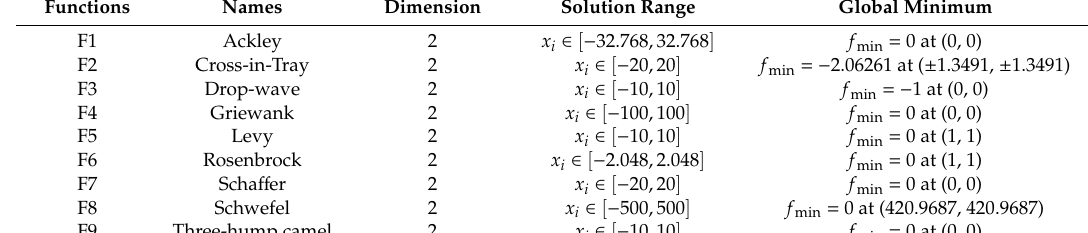
Table A1. Two-dimensional benchmark test functions considered in the simulations.